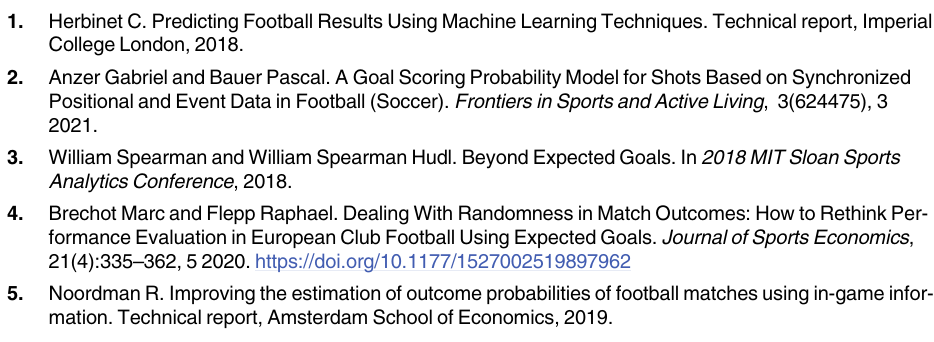
S1 Table. Overview of features included in expected goals models. The first 4 features are categorical features taking the values listed, the rest are numerical values in the ranges